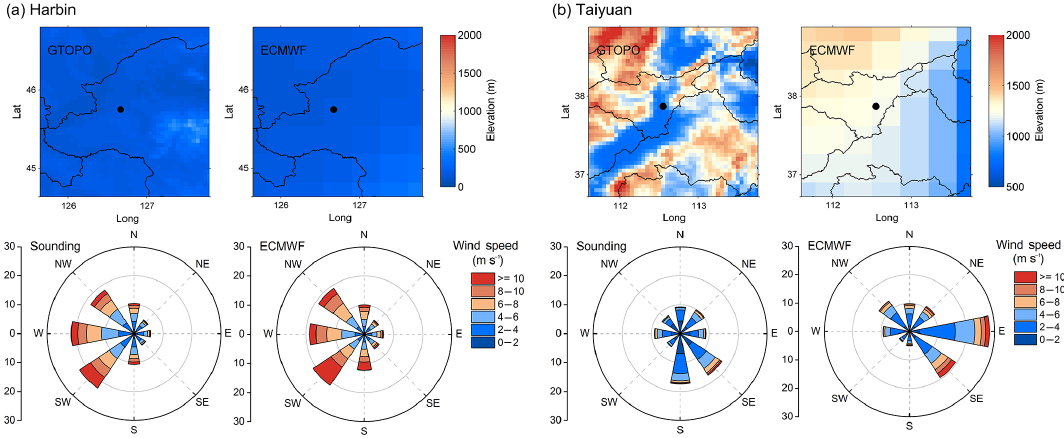
Figure 4. Comparison of the topography (top panel) and wind roses (bottom panel) from ECMWF (right panel) and higher-resolution data sets (left panel) around (a) Harbin and (b) Taiyuan. The land surface elevation on the left panel is derived from GTOPO30. The wind roses on the left panel are generated from sounding measurements assembled by University of Wyoming. Radial units are percent per 45 ◦ direction